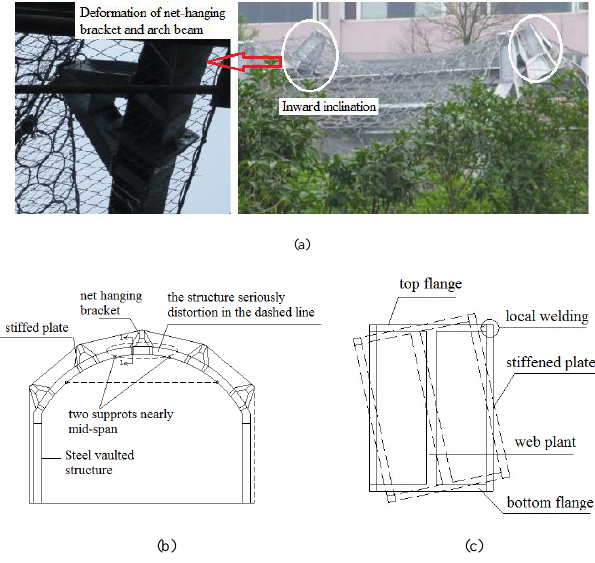
Fig .8. The most serious distortion occurred between the two longitudinal supports nearly Fig. 8. The most serious distortion occurred between the two lon- gitudinal supports nearly mid-span. (a) The picture of the distorted mid-span. (a) The picture of the distorted arched beam; (b) The Schematic distortion arched beam; (b) the schematic distortion drawing of the structure; drawing of the structure; (c) The detail cross sectional deformation of arch beams (c) the detail cross-sectional deformation of arch beams.